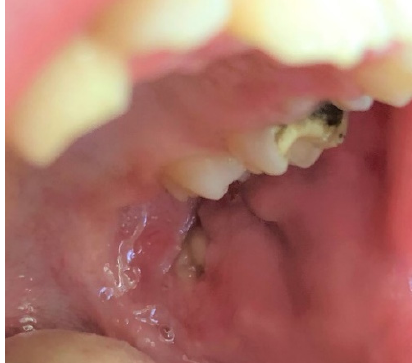
Figure 11. Traumatic ulcer on the left buccal mucosa in a school-age boy. Visible in the picture yellow-gray, oval, well-circumscribed ulceration with rolled border. In this case, the lesion resulted from a parafunctional chewing of the cheek due to school stress.